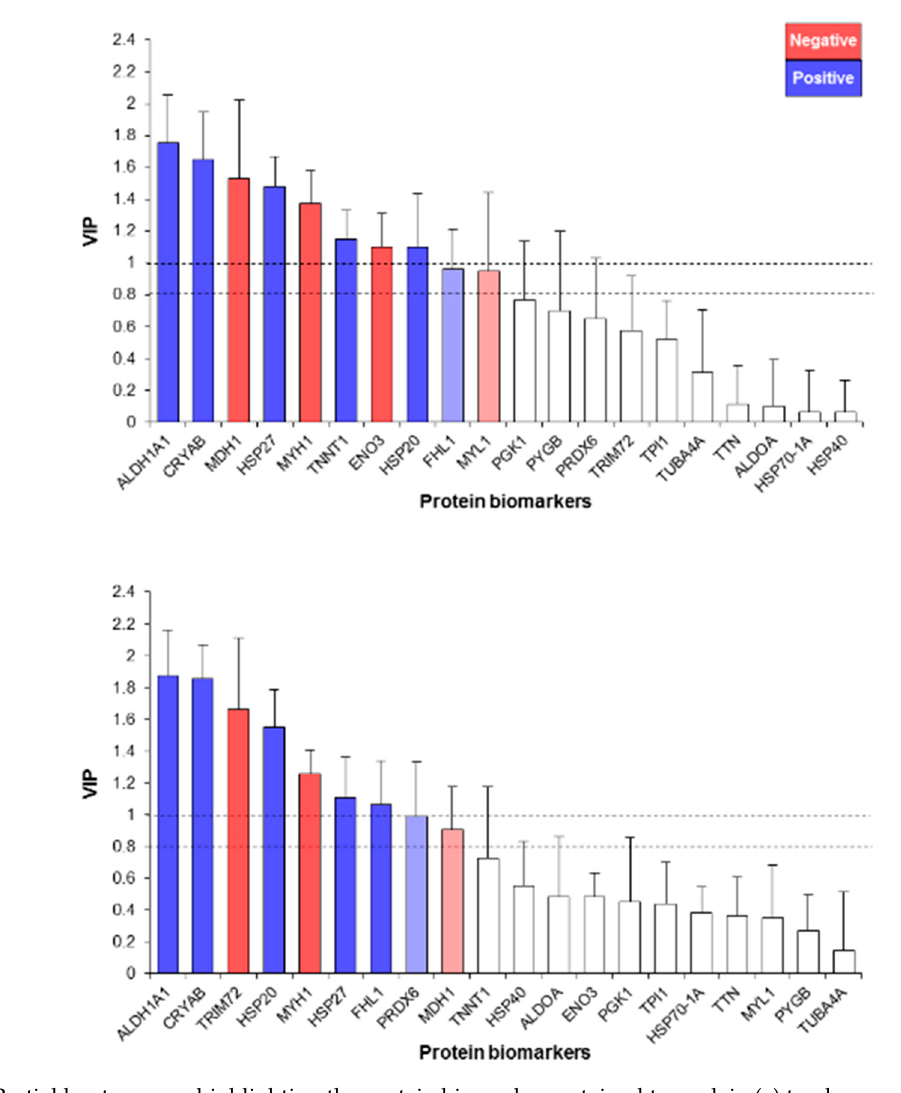
Figure 3. Partial least squares highlighting the protein biomarkers retained to explain ( a ) tenderness evaluated by WBSF and ( b ) IMF content (marbling) based on their variable importance in the projection (VIP). The proteins retained in positive and negative directions are shown in blue and red colors, respectively. For ( a ) WBSF, a total of 10 proteins were retained from which 8 had VIP > 1.0, and for ( b ) IMF, 9 proteins were retained, from which 7 had VIP > 1.0. A total of 7 proteins were common (MDH1, ALDH1A1, CRYAB, HSP20, HSP27, MYH1 and FHL1) in the two models to explain both WBSF and IMF variation.